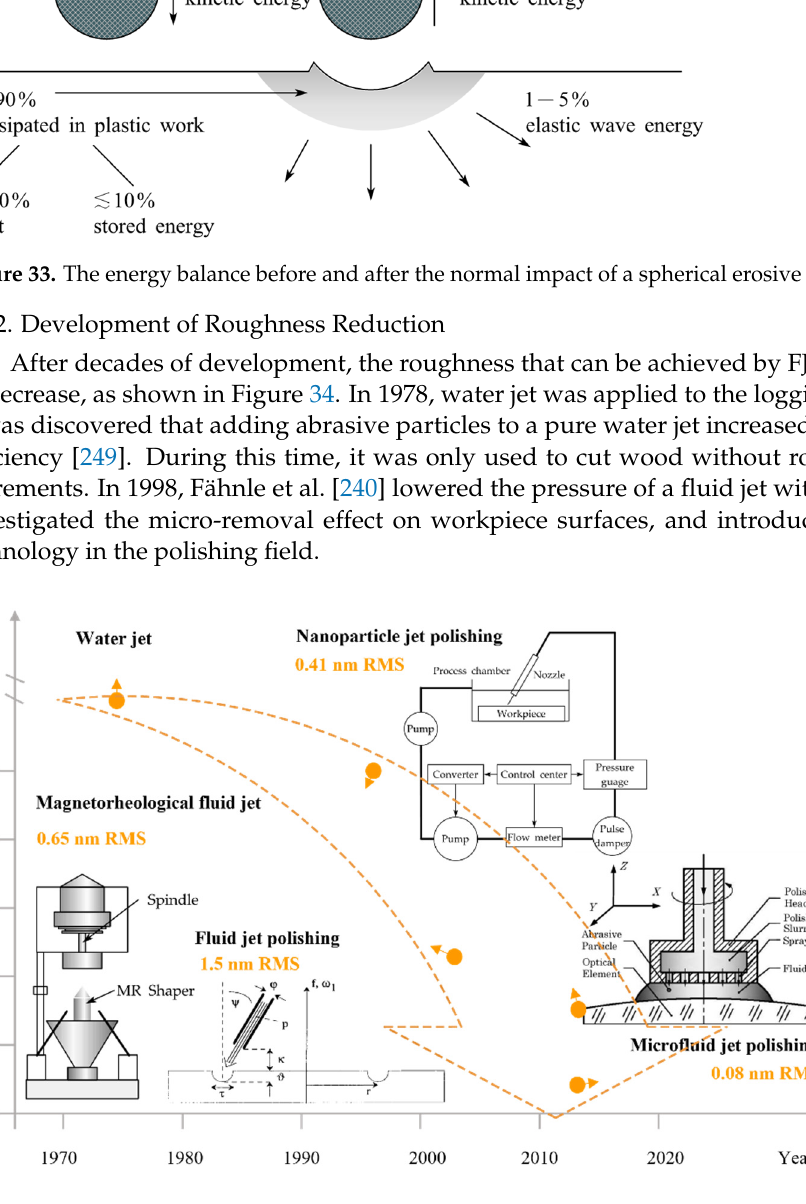
Figure 33. The energy balance before and after the normal impact of a spherical erosive particle [248].